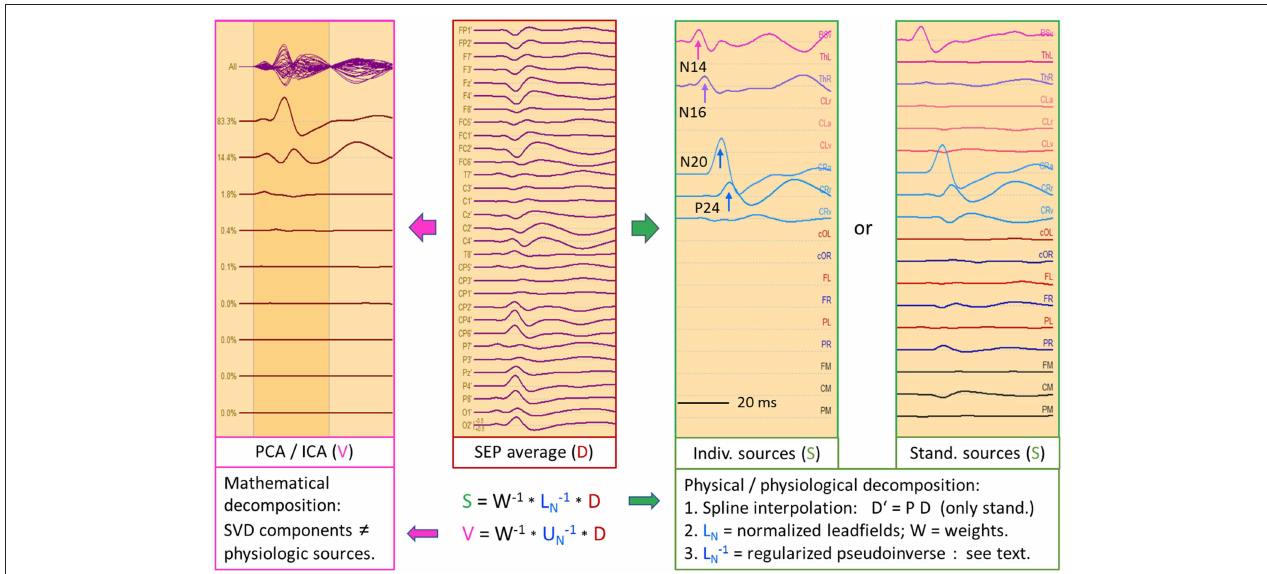
FIGURE 9 | Left median-nerve SEP—same subject, scaling and filtering as in Figure 8 . Here, different types of linear decompositions are illustrated. First, one can use the 5 individual sources as in Figure 8 , mirror locations and orientation from right to left, and adjust orientations to the peaks of N14, N24, and P24. The separation of components is highly similar to Figure 8 , but the generators are now in the right hemisphere, contralateral to stimulation. When using the standard SEP source montage ( right ), one can immediately observe the separation of N14, N20, and P24, although N20 and P24 have not been oriented optimally, so that some activity is shared with the 3rd dipole of CR. The other regions do not contribute to the SEP in this time range and partially shield the deep radial generator of N16 in the right thalamus. This separation in matrix S is enabled by using an appropriate physical and physiological model defined by the leadfields of the sources. If we use a blind, purely mathematical decomposition of the data matrix D, e.g. singular value decomposition (SVD) or ICA, the resulting waveforms V do not show an interpretable decomposition ( left ).